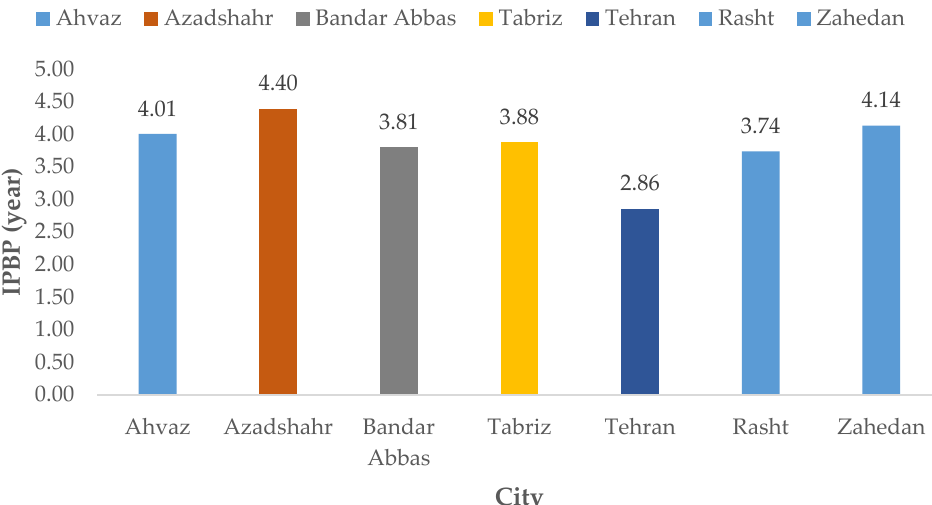
Figure 7. Comparing IPBP for seven investigated cities.